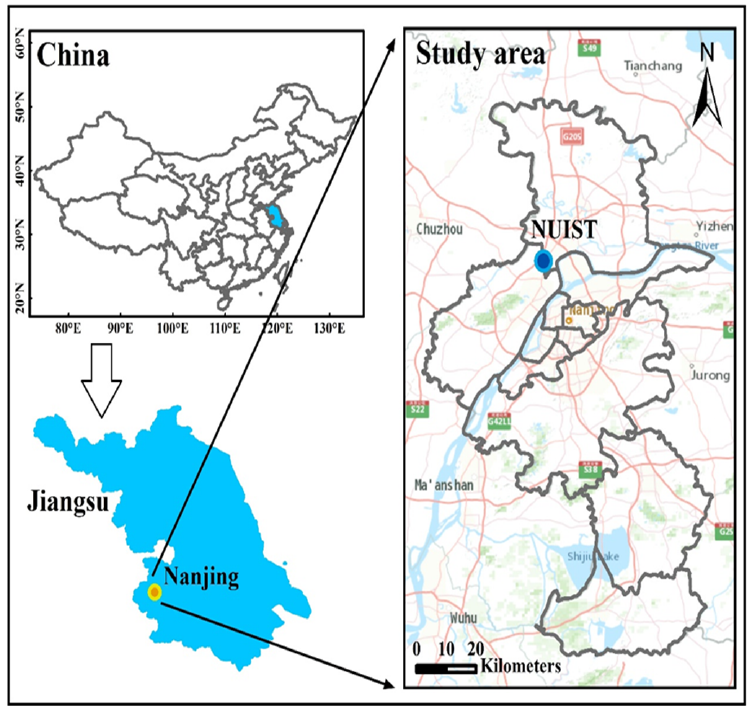
Figure 1. The location of the sampling site.